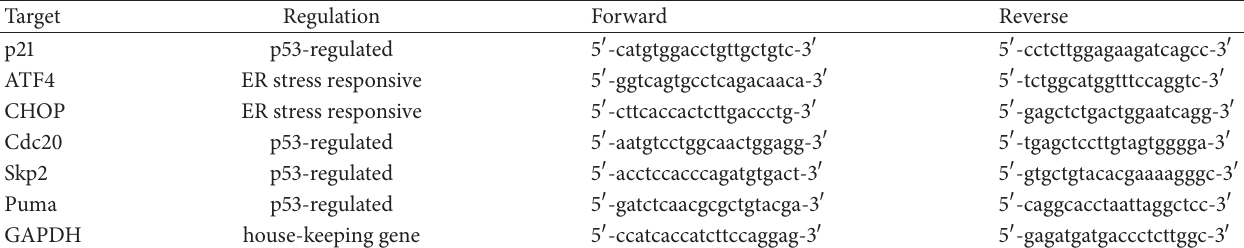
Table 1: Primers for real-time PCR.